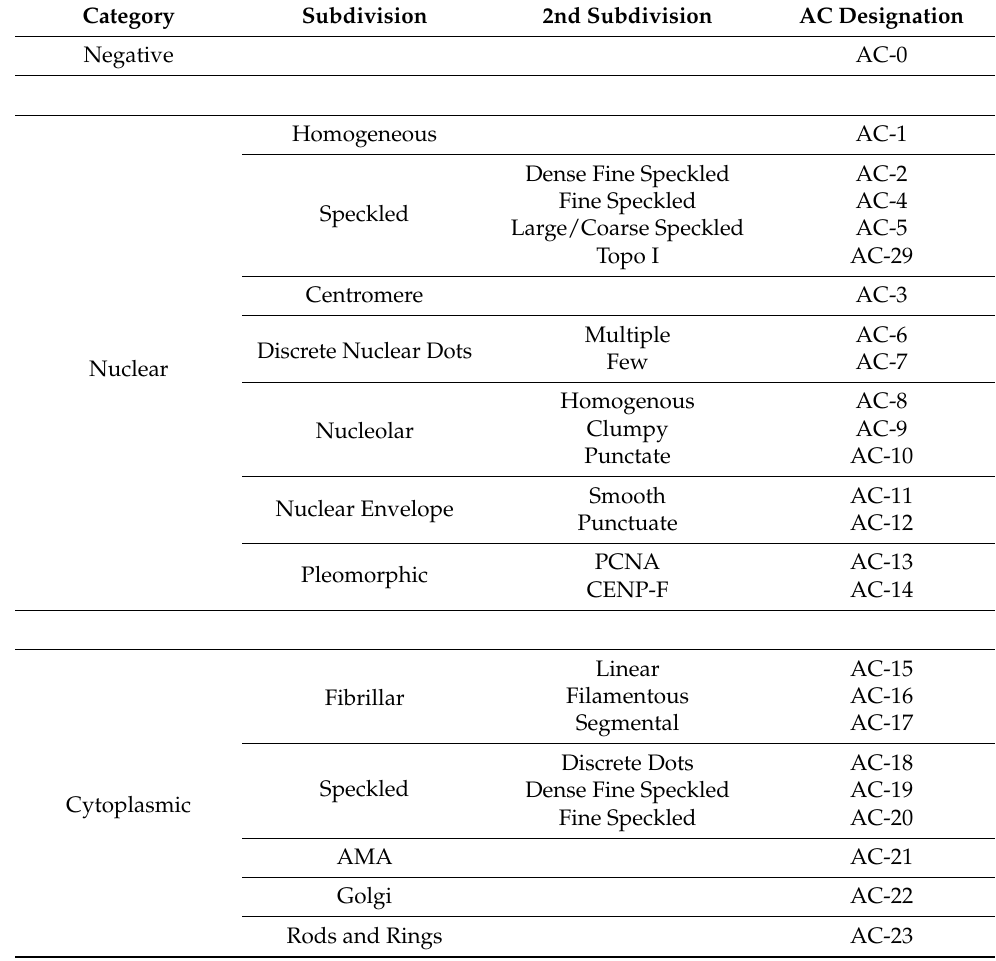
Table 1. Nomenclature and classification of antinuclear antibody (ANA) indirect immunofluorescence (IIF) patterns on HEp-2